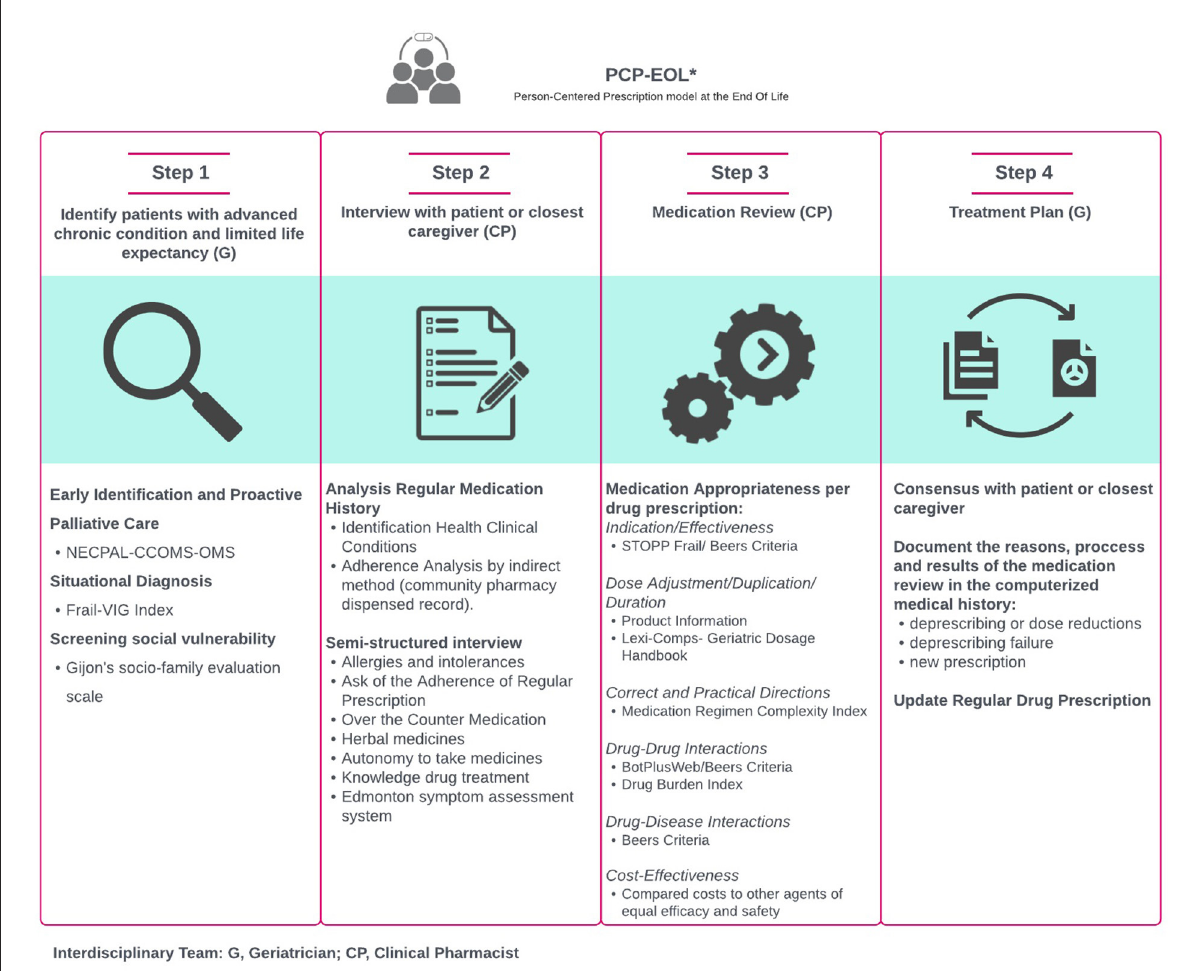
FIGURE1 Person-centered prescription model at the end of